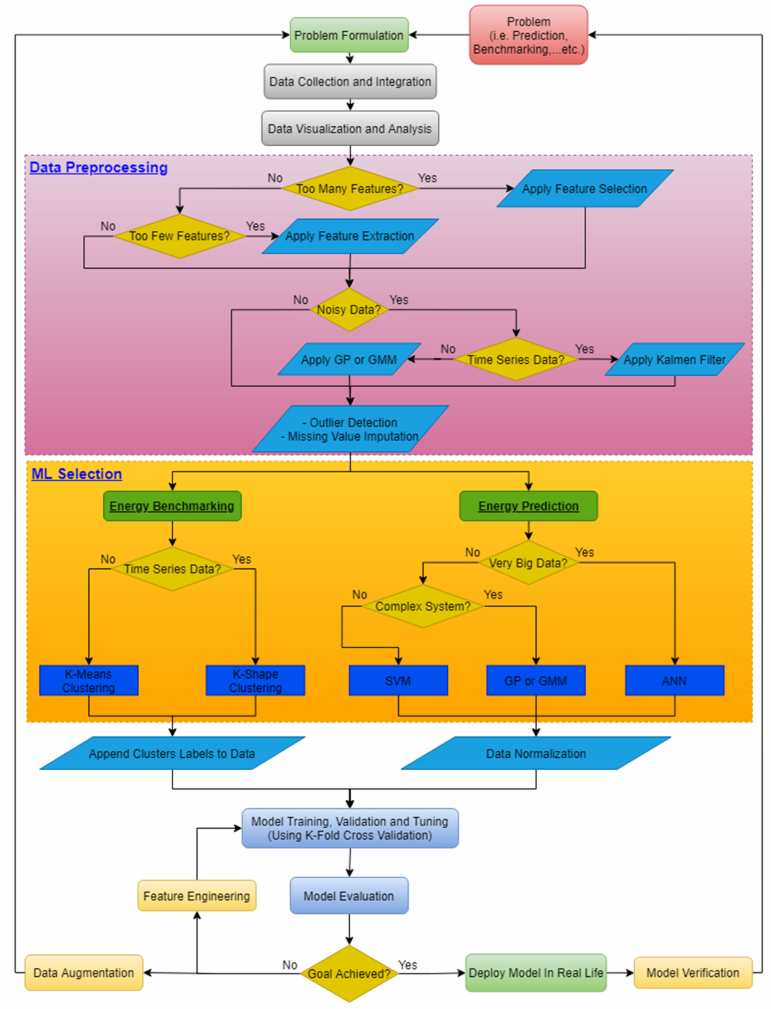
Figure 2. Building energy prediction and benchmarking